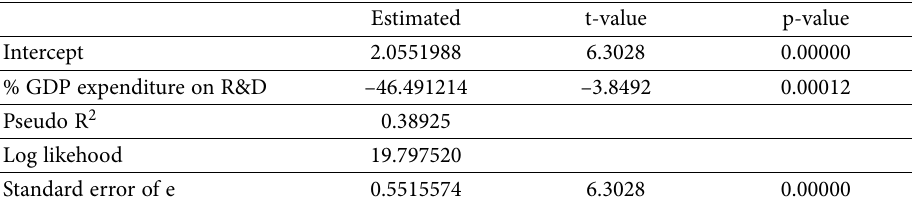
Table 6. Tobit regression statistics